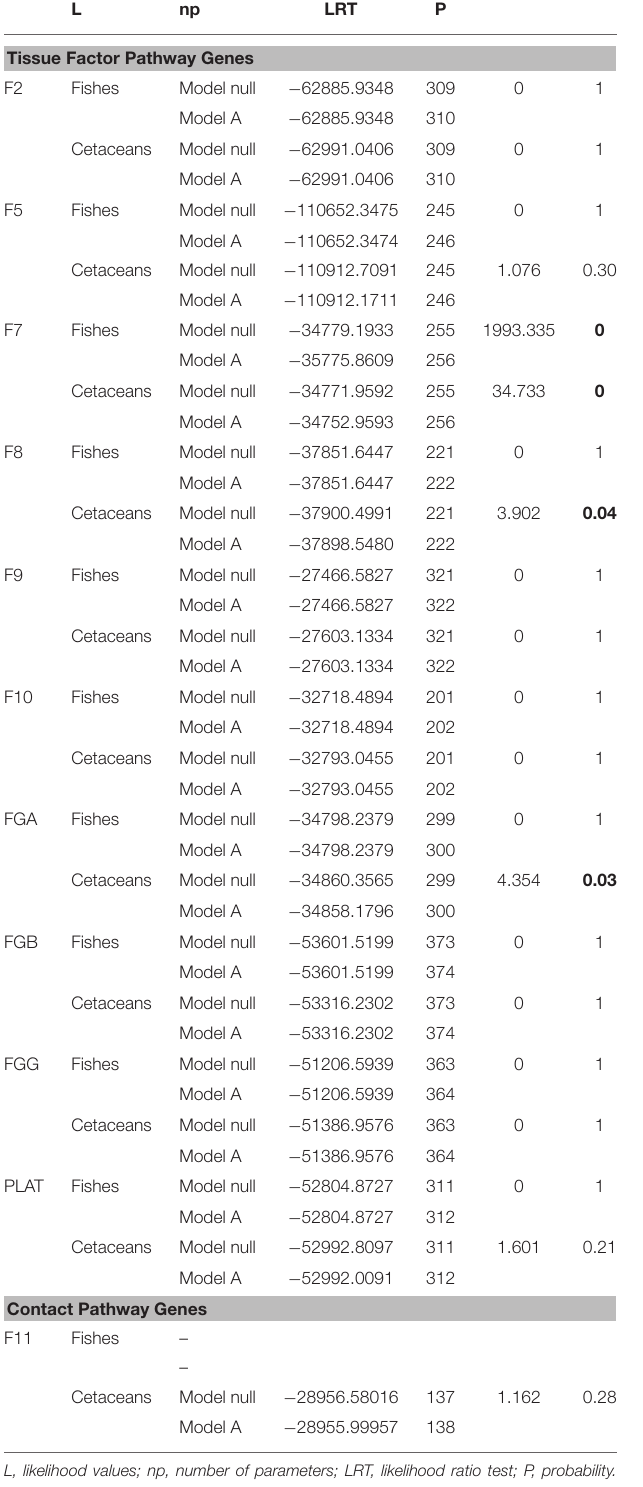
TABLE 1 | PAML branch-site tests the null model ( ω = 1) against the model A (which allows ω > 1 in the foreground branch) and of evolution rates. L np LRT P Tissue Factor Pathway Genes